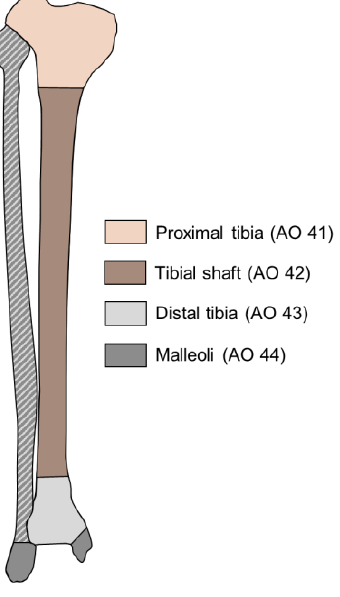
Figure 1. Fracture locations of the lower leg. The fibula can be involved in both distal tibial fractures as well as malleolar fractures. The distal tibia may also be involved in malleolar fractures. The AO classification numbers associated with the fracture locations are provided between brackets.